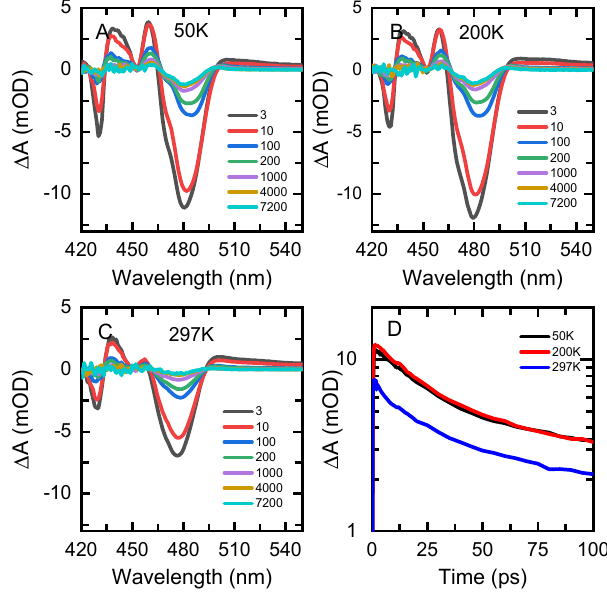
Figure 4. Transient absorption spectra of perovskite sample with a 100% excess of RbBr at 50 °K ( A ), 200 °K ( B ), and 297 °K ( C ) with different delays between pump and probe pulses (indicated) and the time evolution of the transient absorption signal at 475–480 nm at different temperatures (indi- cated) ( D ).